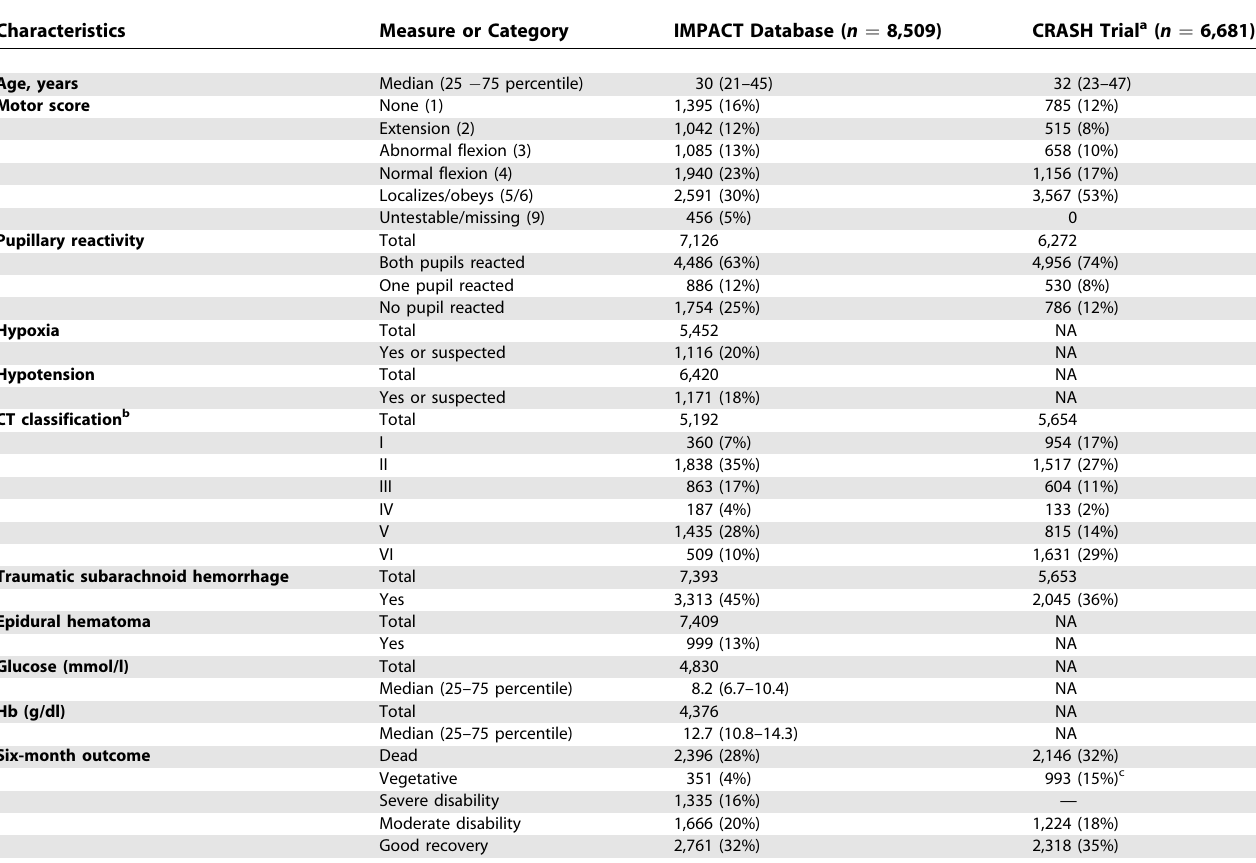
Table 1. Patient Characteristics of 11 Studies in the IMPACT Database and the CRASH Trial